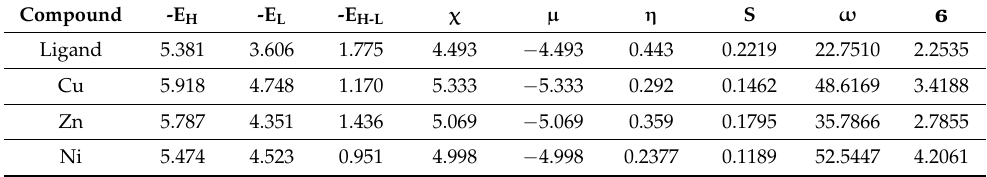
Table 10. Some quantum chemical parameters of azodicarbonamide and its complexes.